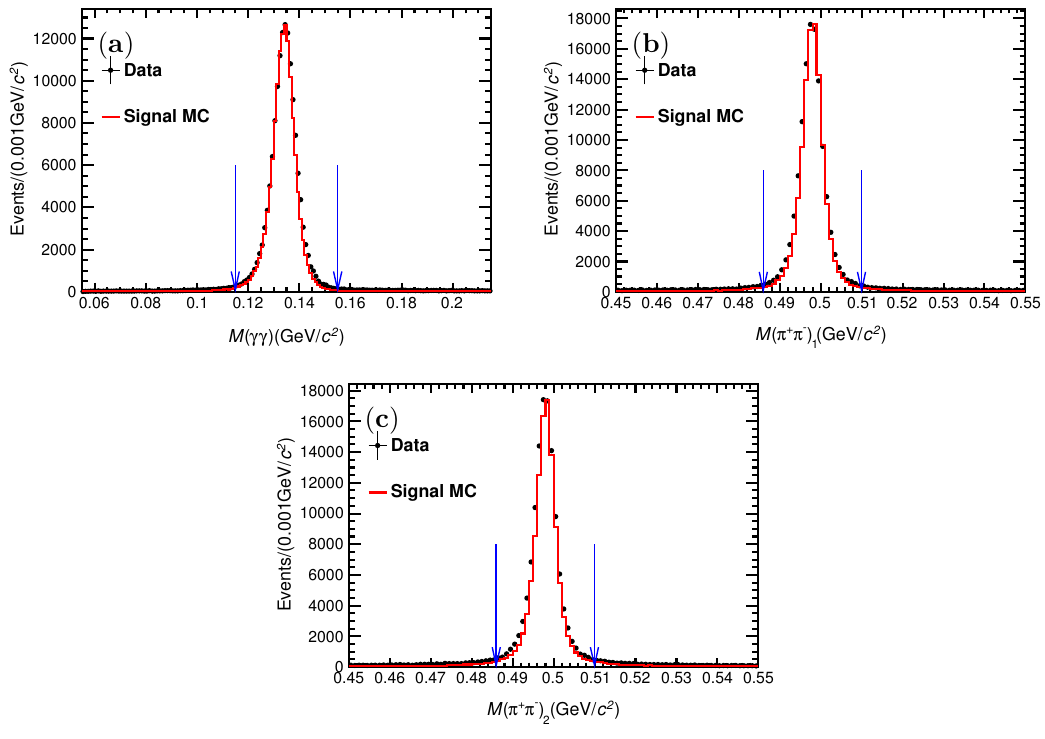
Figure 1 . Invariant mass distributions of (a) γγ , (b) one π + π − pair, (c) another π + π − pair for candidate events with the 4C kinematic fit applied. Dots with error bars are data and the red solid line represents the signal MC sample (normalized by